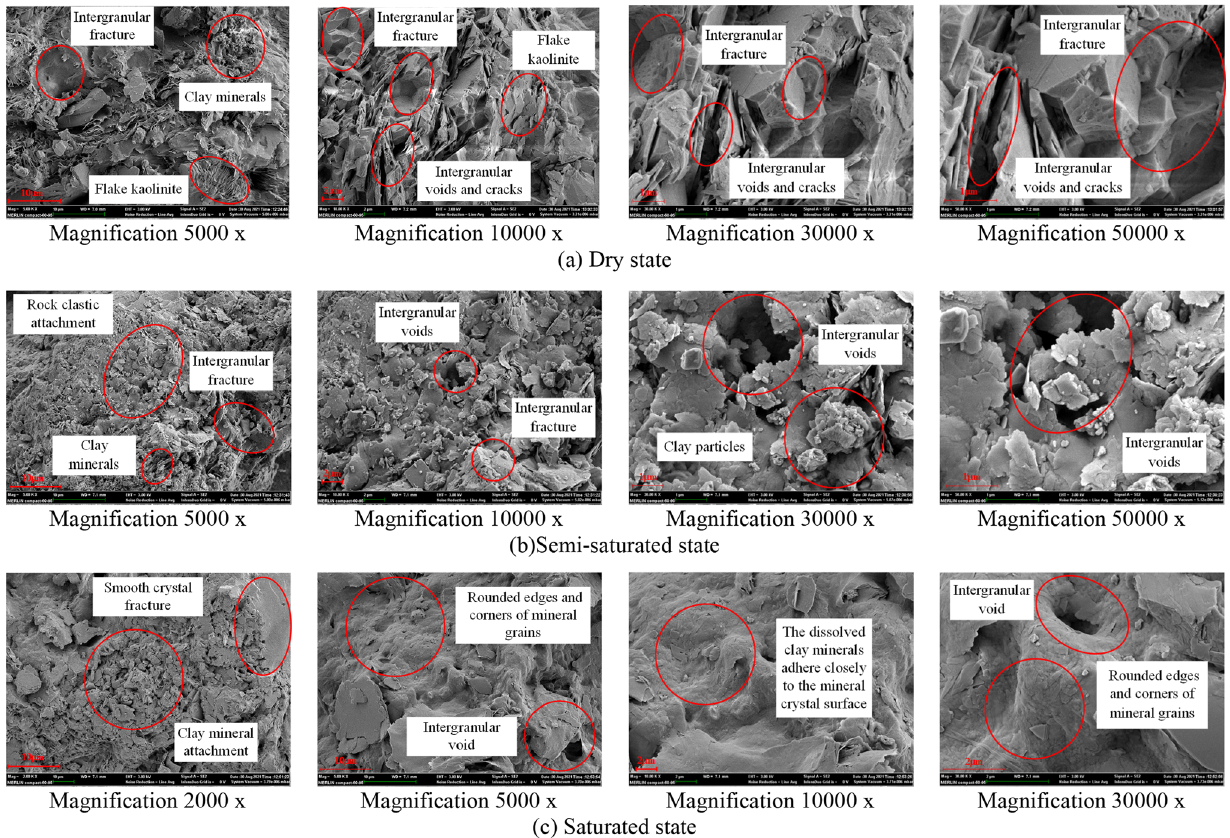
Fig.13 Micro-structural characteristics of sandstone